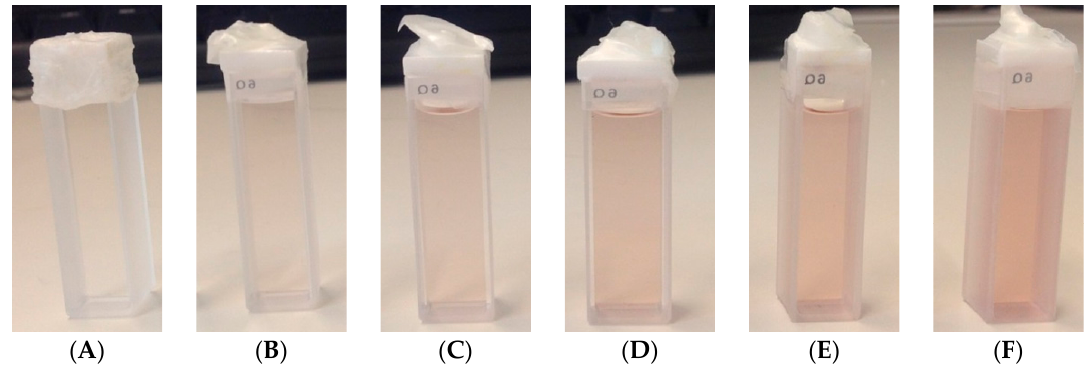
Figure 5. GNR solutions of various concentrations (refer to Table 1). ( A ) 0 GNRs/mL, ( B ) 1.04 × 10 11 GNRs/mL, ( C ) 2.08 × 10 11 GNRs/mL, ( D ) 3.12 × 10 11 GNRs/mL, ( E ) 4.16 × 10 11 GNRs/mL and ( F ) 5.20 × 10 11 GNRs/mL.